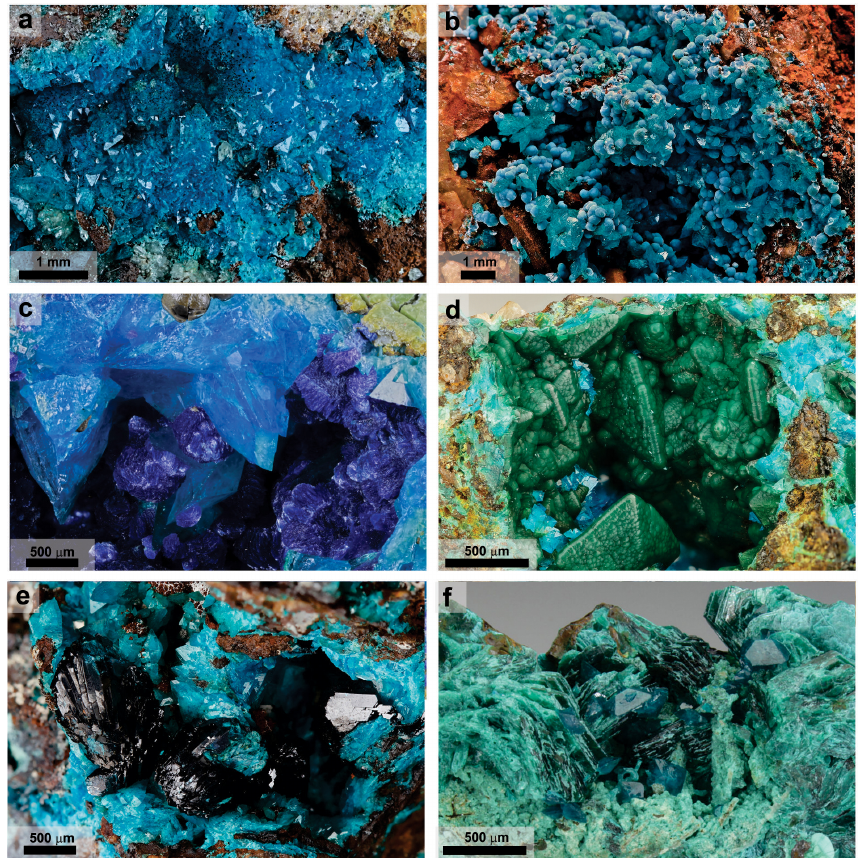
Figure 5. (a) Liroconite growing on greenish scorodite. (b) Ceruleite (spherical aggregates) with liroconite crystals. (c) Liroconite over- grown by azurite crystals. (d) Pseudomorphs of cornwallite after liroconite. (e) Clinoclase growing on liroconite. (f) Liroconite crystals with chalcophyllite (greenish tabular crystals). All samples from Wheal Gorland, England. Table 10. Molar thermodynamic functions for pushcharovskite, Cu ( AsO 3 OH )( H 2 O ) · 0 . 5H 2 O, molecular mass 230.4945gmol − 1